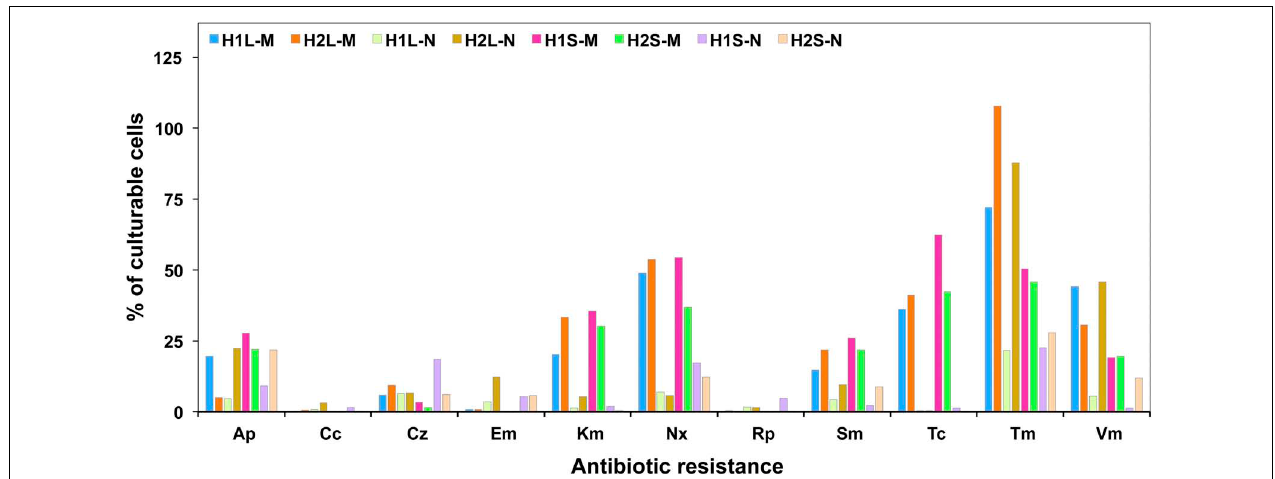
FIGURE 2 | Relative abundance of culturable resistant bacteria in waters and sediments of the sampling sites.